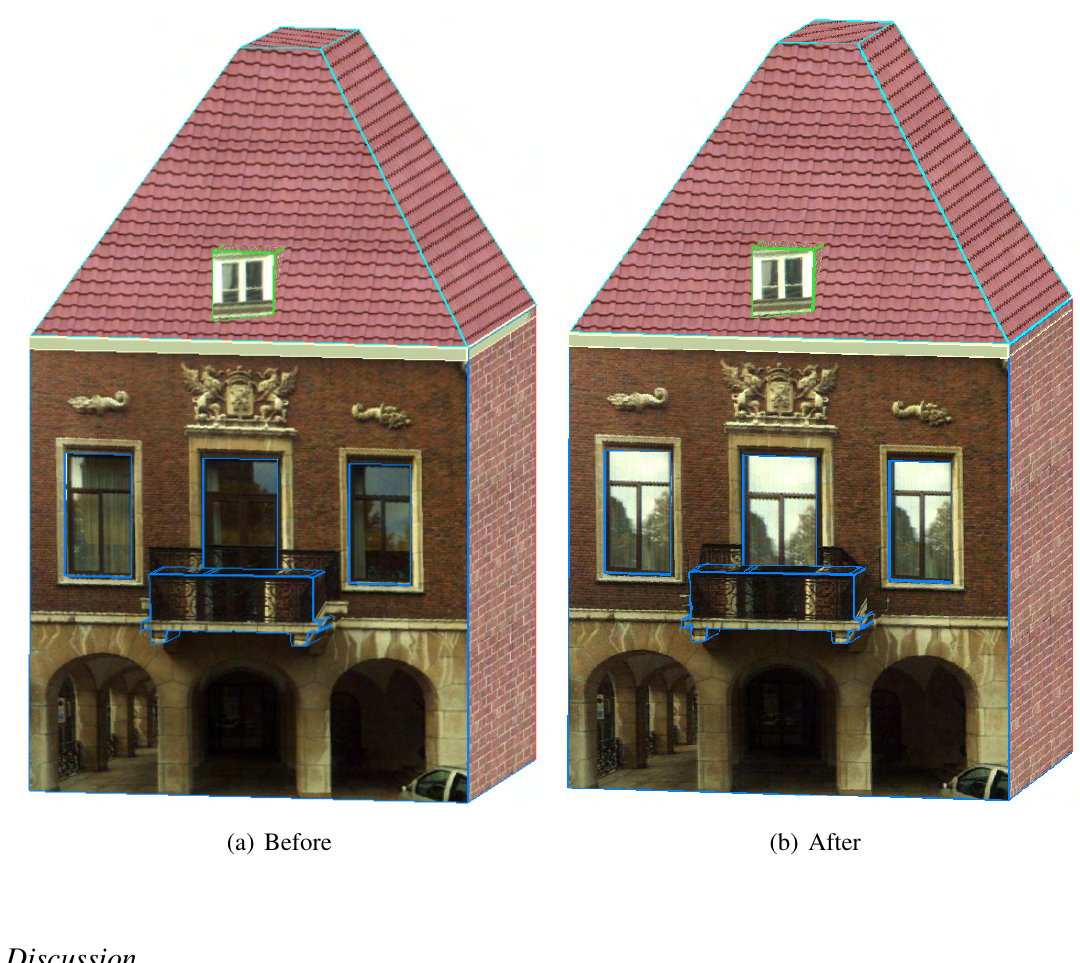
Figure 13. A reconstructed facade model before and after removing occluded